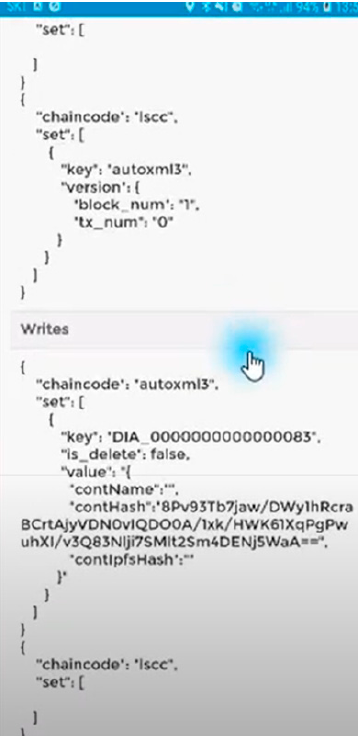
Figure 16. Legacy inheritances smart contract hash storage screen.